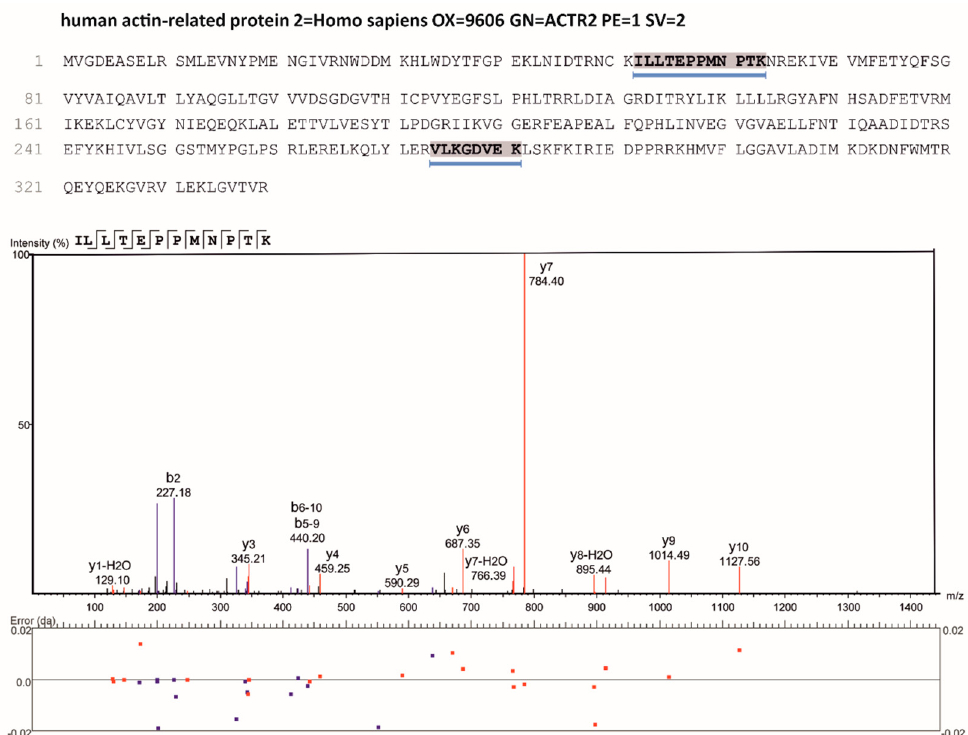
Figure 6. Mass spectrometric identification of human Arp2 unique peptides. Fluorescently labelled band after IP as shown in lane 5 of Figure 5G was excised from a similar SDS-PAGE gel and digested with trypsin as detailed in Materials and Methods. Two tryptic peptides (residues 52 till 63 and 274 till 281) unique to human Arp2 (gene: ACTR2) were identified by nanoLC-MS/MS (highlighted in the protein sequence). The lower part shows the fragment ion spectrum (HCD) of one of the identified tryptic peptides demonstrating high peptide sequence coverage and thus reliable identification of Arp2.